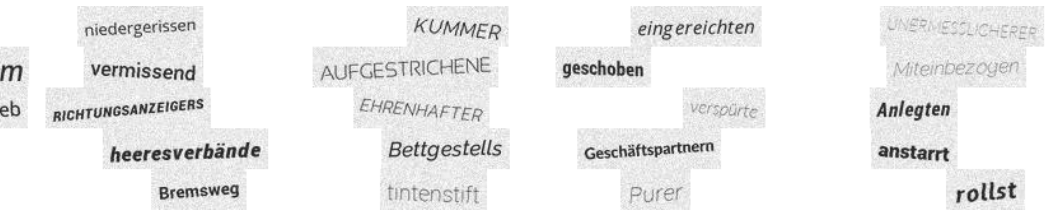
Figure 13. Sample German words generated by our Python module for training the text recognition for German words.